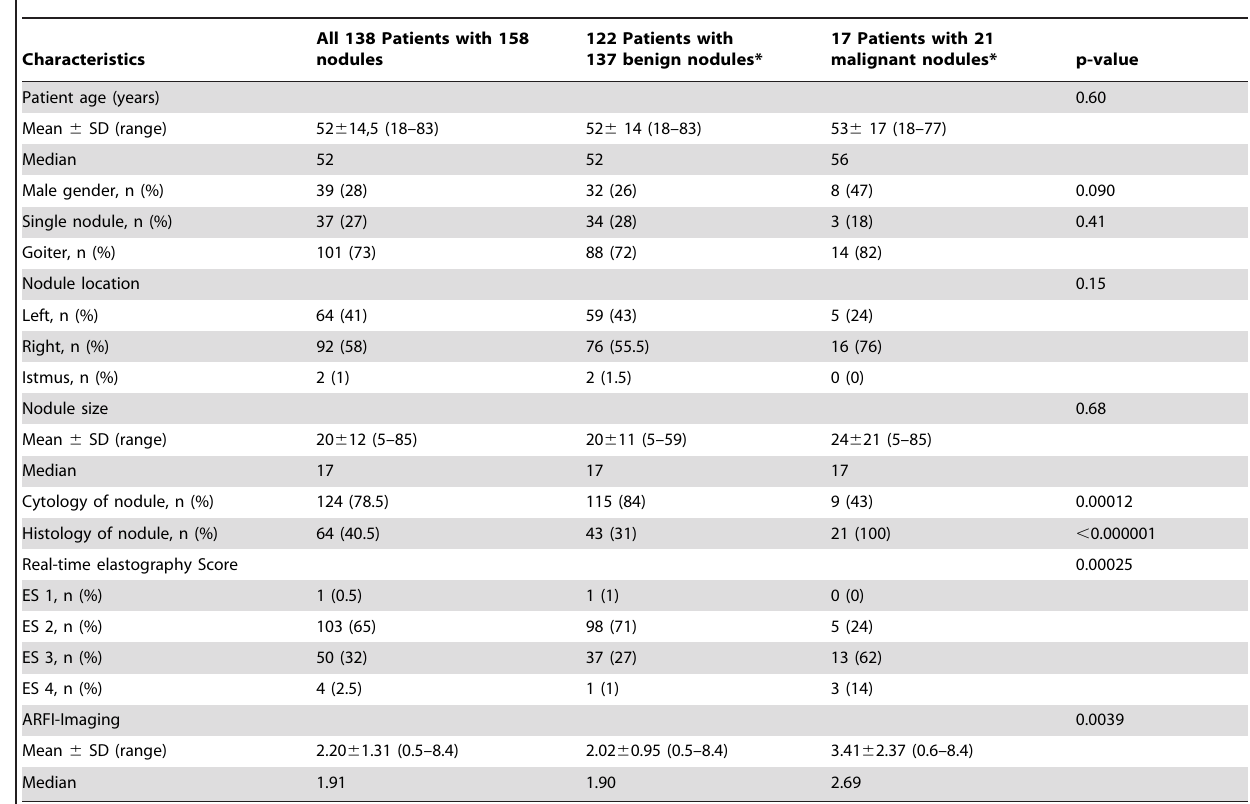
Table 1. Patient